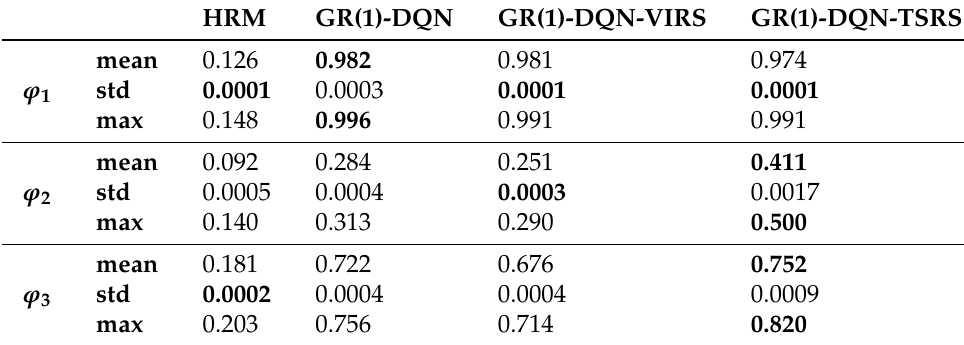
Table 2. The mean, max and standard deviation of learning curves from specification ϕ 1 , ϕ 2 and ϕ 3 starting from training step